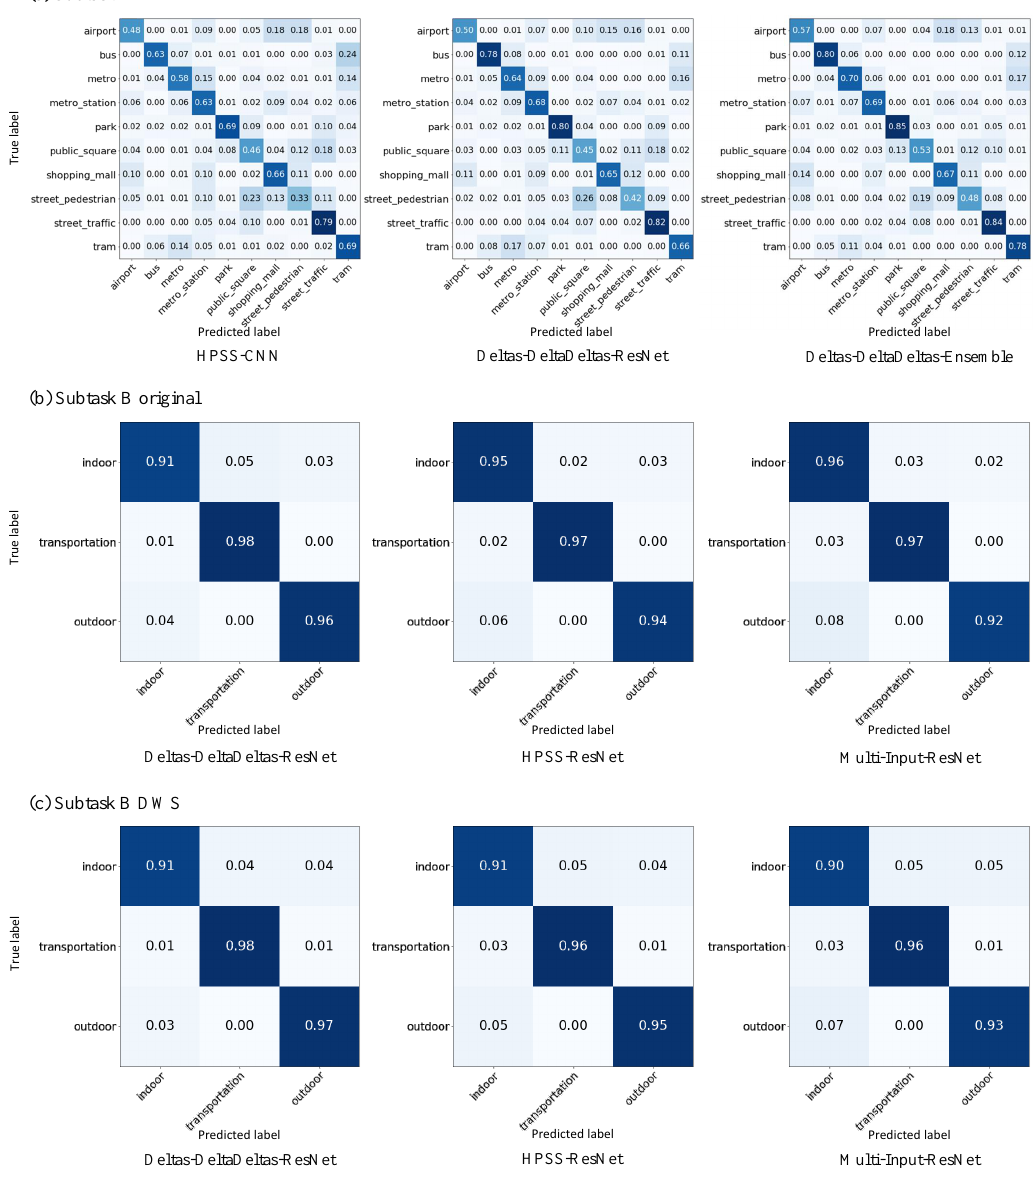
Figure 7. Class-wise performance on subtask A and B. ( a ) shows class-wise performance for each model of subtask A, ( b ) is class-wise performance for models in subtask B to which DWS is not applied, ( c ) is class-wise performance of models to which DWS is applied in subtask